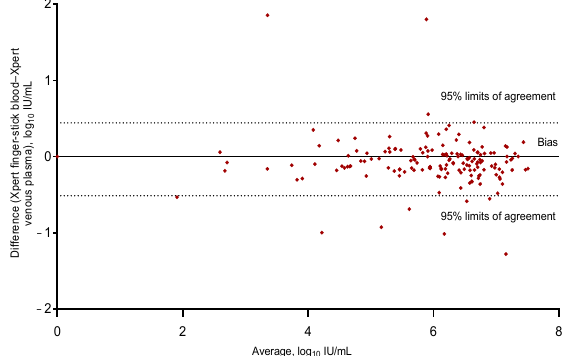
Figure 3. Bland–Altman bias plot of differences for the Xpert HCV VL Fingerstick Assay for HCV RNA detection in fingerstick capillary whole-blood samples compared with the Xpert HCV Viral Load Assay for HCV RNA detection in venous plasma (with two discrepant results excluded from the analysis); n = 297, bias − 0.03643, 95% limits of agreement − 0.51 to 0.44. HCV: hepatitis C virus .